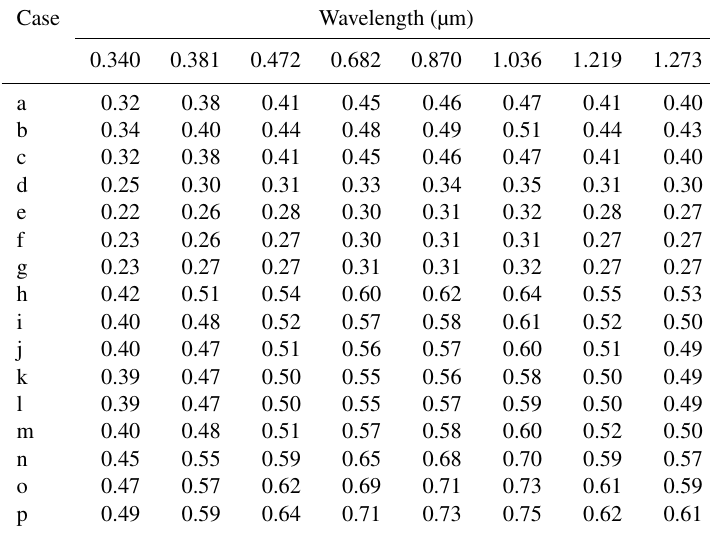
Table 4. Measured spectral albedo (with atmosphere) for each BRDF